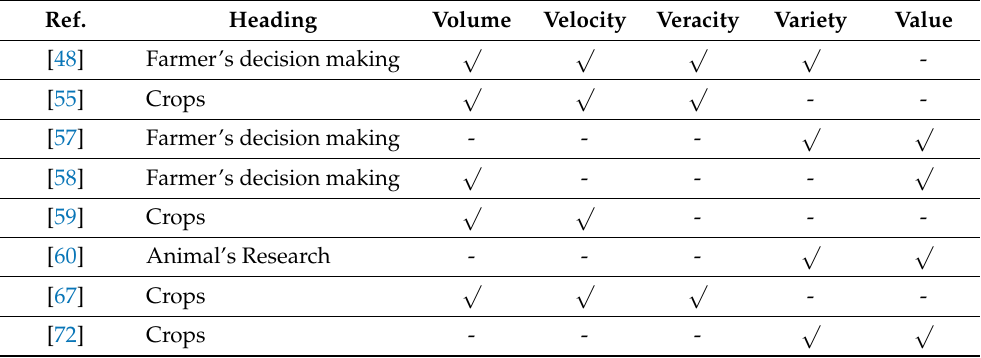
Table 13. ML adaptations for Big Data architectures in agriculture. Ref.